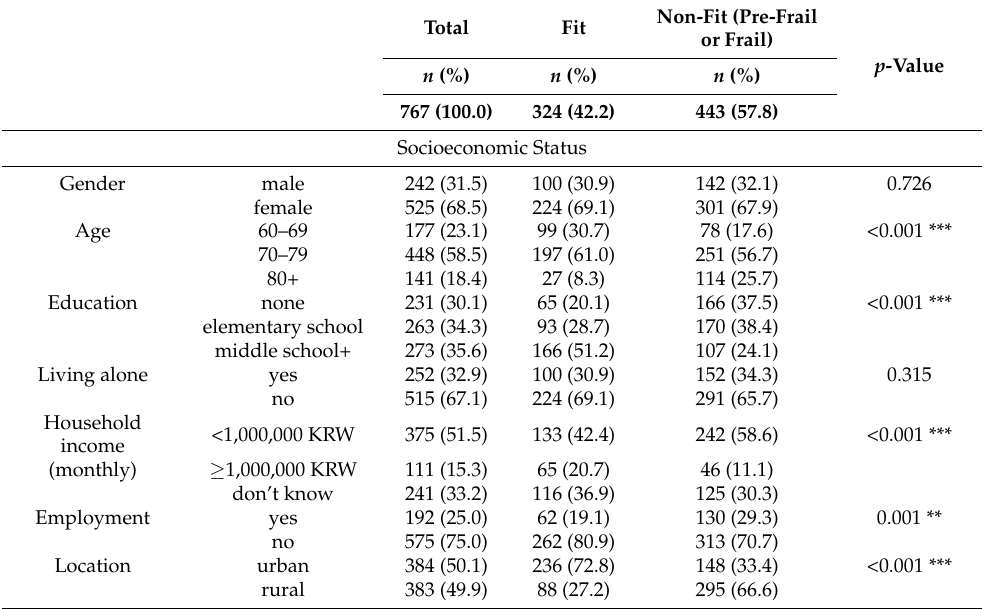
Table 2. General characteristics of the study population by frailty at